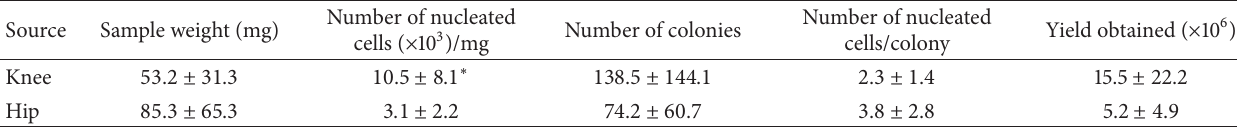
Figure 2: (a) Arthroscopic observation and sample harvesting. (b), (c) Macroscopic features of from knee and hip synovium were examined on a 1mm scare and in PBS. (d), (e) Histological analysis was performed on tissues stained with hematoxylin and eosin (HE). (f) Representative cell colonies derived from synovium of a donor stained with crystal violet showing large colonies when the nucleated cells were plated at 10 4 cells/dish. There was no significant difference in the number of colonies between both MSCs from knee and hip joints. (g) Representative morphologic features of the cells magnified at 14 days (passage 0) showing fibroblastic spindle cell morphology. Bar = 100 𝜇 m. (h) Representative cell colonies stained with crystal violet derived from the synovial fluid of a donor showing large colonies from the knee, but no colonies from the hip. Table 2: Data on cell samples obtained from the synovium of 8 donors. Values are shown as mean ± standard deviation. Nucleated cells were plated at 10 4 /60 cm 2